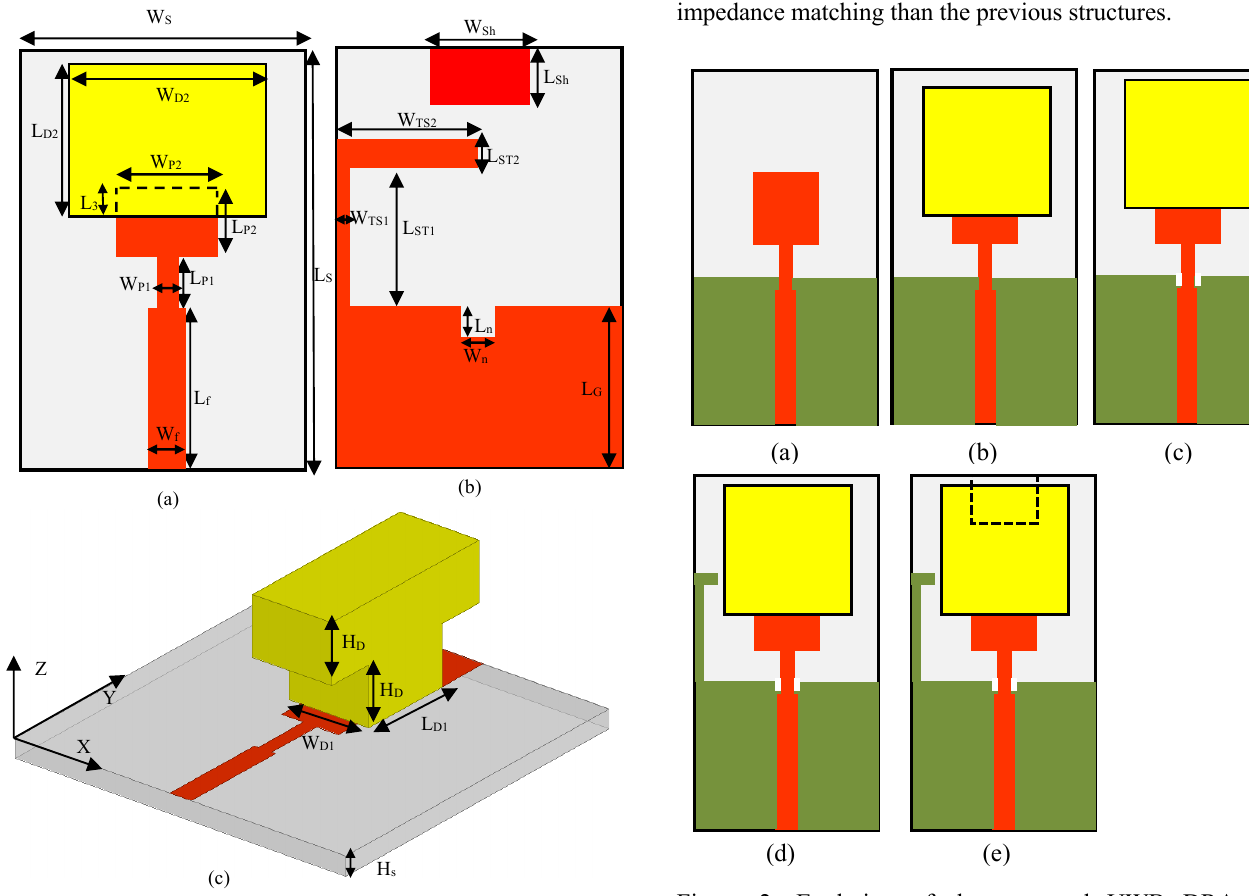
Figure 2: Evolution of the proposed UWB DRA. (a) Monopole antenna. (b) Monopole antenna loaded with the DR. (c) Monopole antenna loaded with the DR and the added slot in the ground plane. (d) Monopole antenna loaded with the DR and the added slot in the ground plane and added L-shaped tuning stub. (e) The proposed